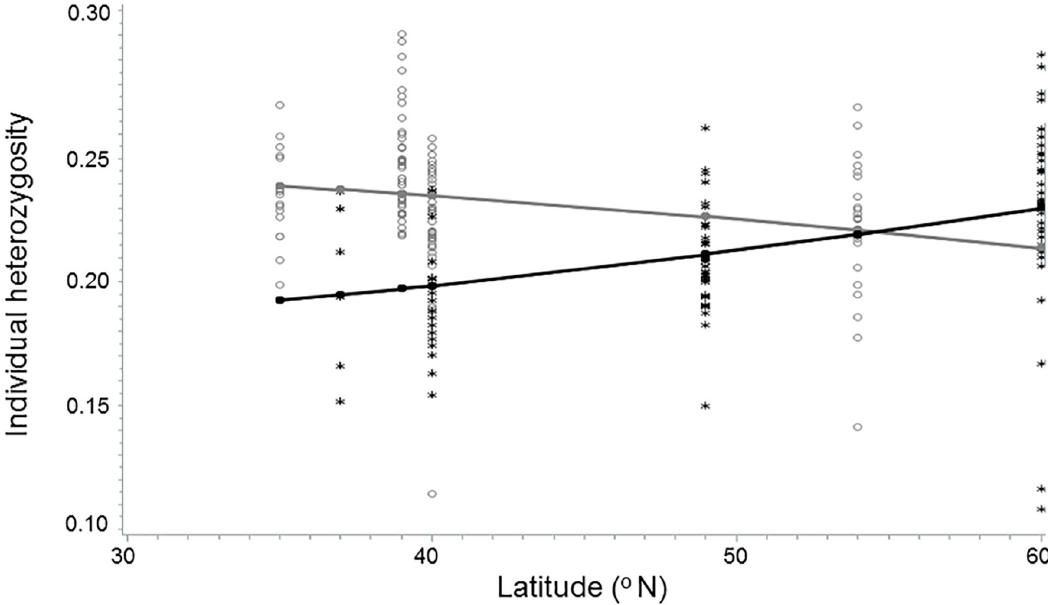
Fig 5. Individual heterozygosity for Lythrum salicaria individuals germinated from seeds collected along latitudinal gradients in Eurasia and North America (filled black circle/line vs. gray circle/line, respectively). Lines were fitted incorporating linear, second order polynomial and log linear equation components in PROC GLMSelect. Interpolated lines follow predicted values for Eurasia and North America (“ � ” vs. “ � ”,